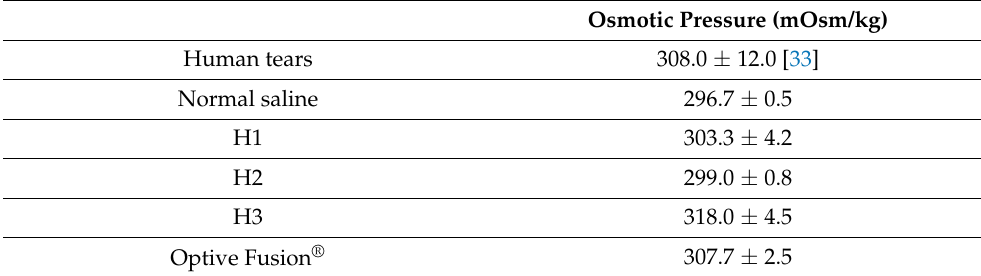
Figure 2. The representative 1 H NMR spectra of ( A ) nimesulide-NH 2 (d 6 -DMSO, nt = 200, DMSO: 2.50 ppm), ( B ) HAH (D 2 O, nt = 200, D 2 O: 4.67 ppm), and ( C ) HAH-nimesulide H2 (D 2 O, nt = 200, D 2 O: 4.67 ppm) (Vnmr-400 MHz, Agilent). The molecular structures were shown on the right, and the number assignment of the signals on the NMR spectrum was corresponding to the hydrogen on the structure. Table 1. The osmolarity of human tears, artificial tears, and HA conjugate solutions.